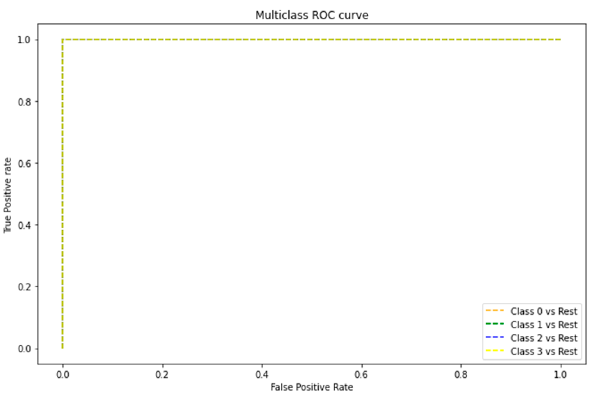
Figure 9. ROC curve graph of the classes that represent the freshness of tuna meat.